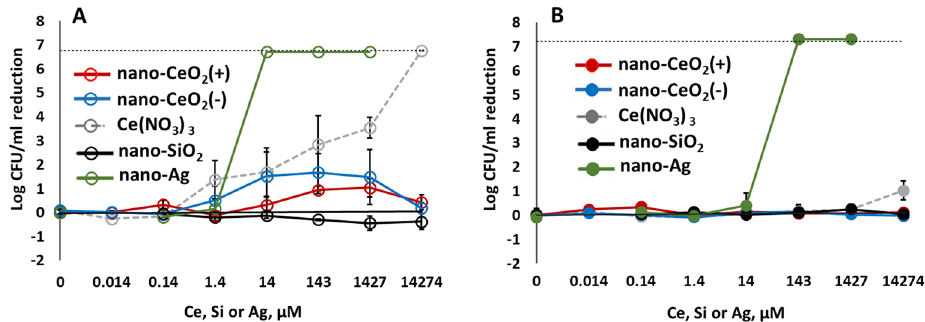
Figure 6. Bactericidal activity after 1 h exposure to nano-CeO 2 , Ce(NO 3 ) 3 , nanoparticles of SiO 2 and Ag against Gram-negative Escherichia coli ( A ) and Gram-positive Staphylococcus aureus ( B ). Bactericidal activity is expressed as log reduction in viable counts compared to unexposed control after 1 h. Results of three independent experiments with standard deviation are expressed as reduction of log CFU/ml. The dotted line indicates a limit of